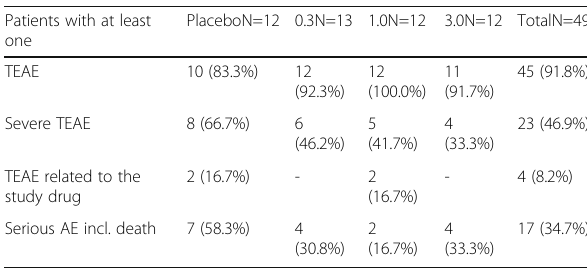
Table 1 (abstract P1). Treatment emergent adverse event and serious adverse event Patients with at least one